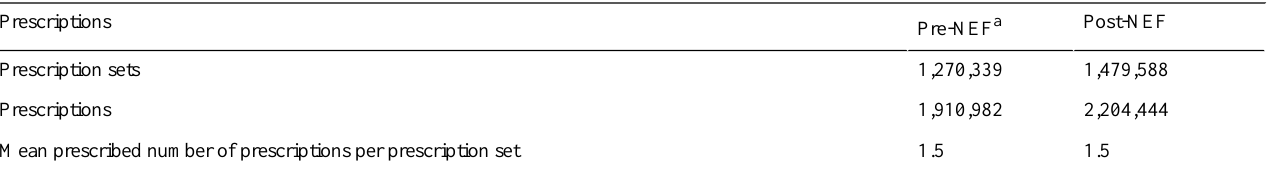
Table 5. Sampled prescriptions—pre-NEF and post-NEF.